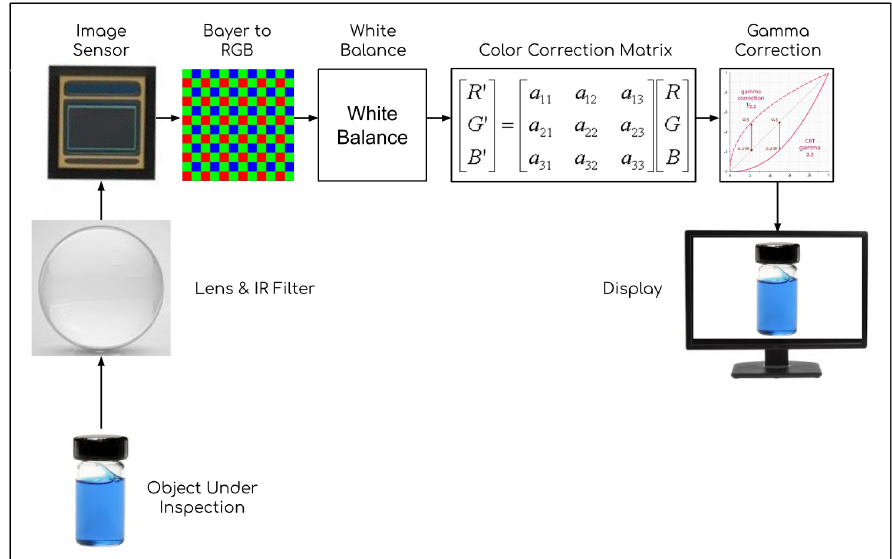
Figure 10. Measured colours.